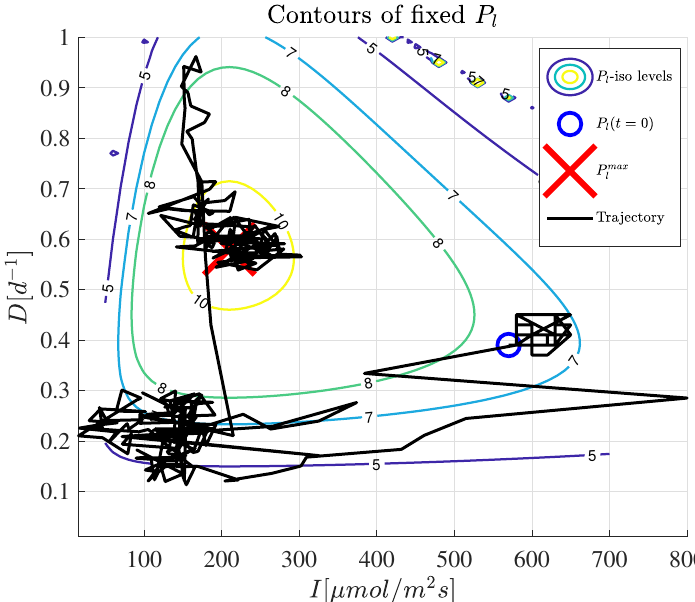
Figure 5. Level lines of the performance index in the plane ( D , I ) and corresponding productivity P l . Figure 7 confirms that PPC with integral action behaves as expected, the latter showing good performance during the transient phases despite the dependence on the estimate convergence and